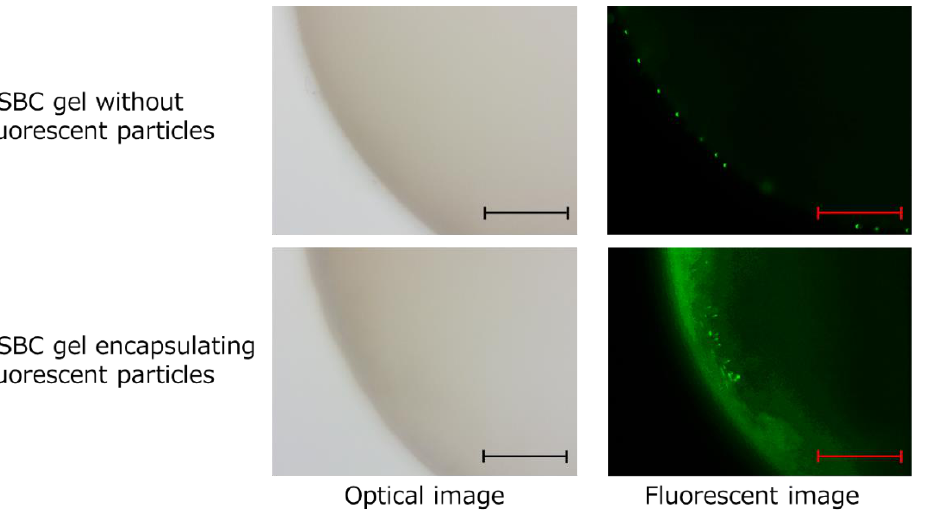
Figure 10. Photographs of the blank HSBC gel immersed in fluorescent particles aqueous solution and HSBC gel encapsulating fluorescent particles. Scale bar: 300 µm.